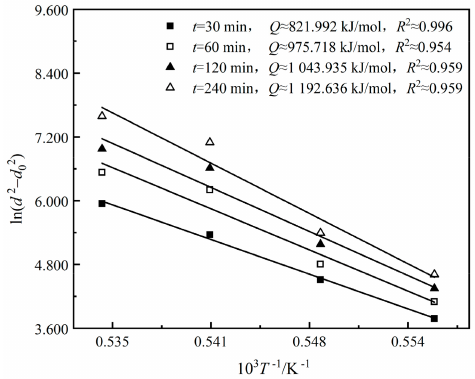
Figure 4. Linear relationship curve between ln ( d 2 − d 2